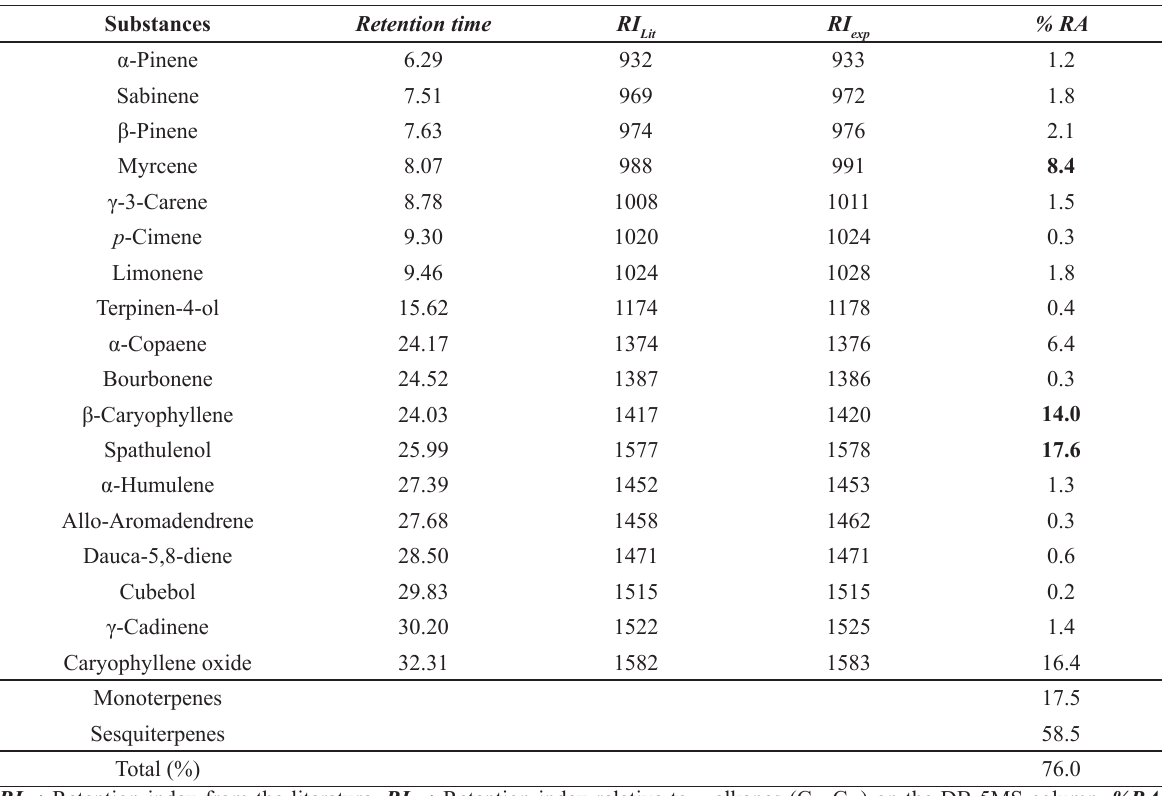
Substances identified in the essential oil from Protium ovatum